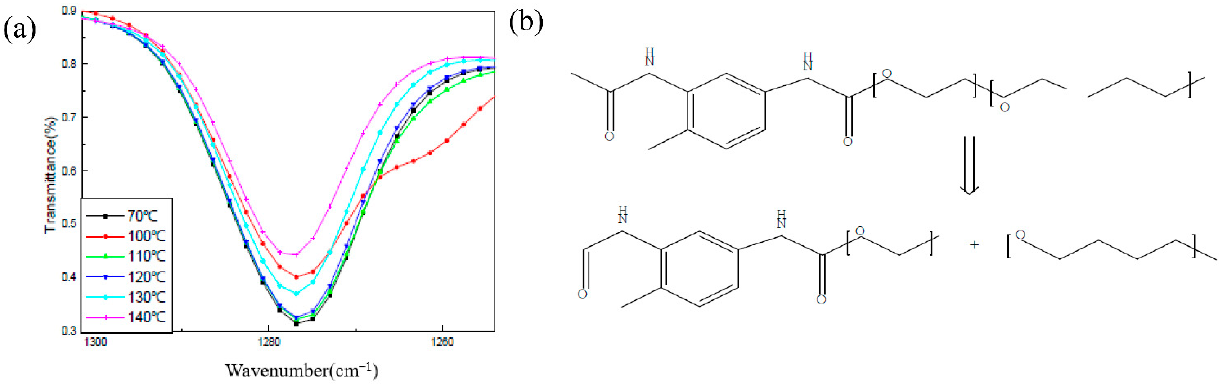
Figure 13. ( a ) Change trend of C–O–C relative absorbance and ( b ) decomposition reaction